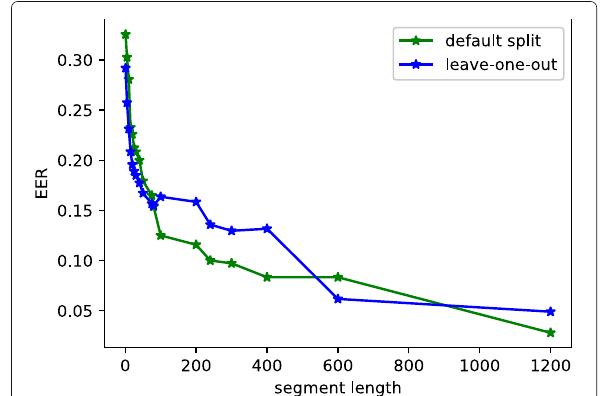
Fig. 8 EERs obtained when the gait normality index was estimated on different lengths of posture